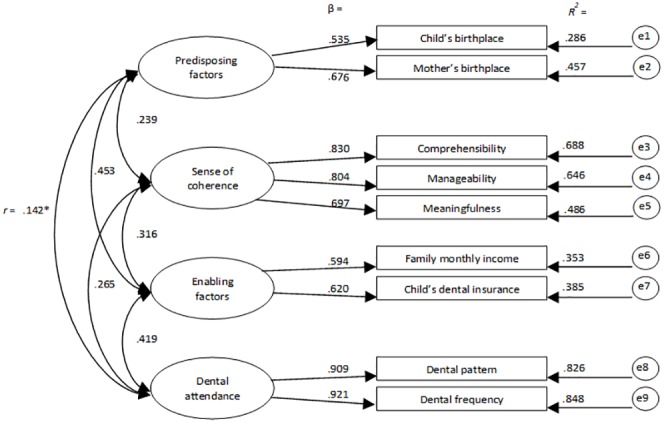
Bootstrapped ML standardised estimates for the confirmatory factor analysis.For all pathways p < 0.01 except *.